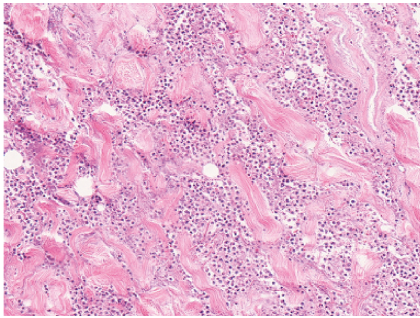
Figure 4: Histopathological findings. Histopathology of debrided tissues showing massive infiltration of neutrophils in muscular layers with necrosis (hematoxylin and eosin stain; magnification ×